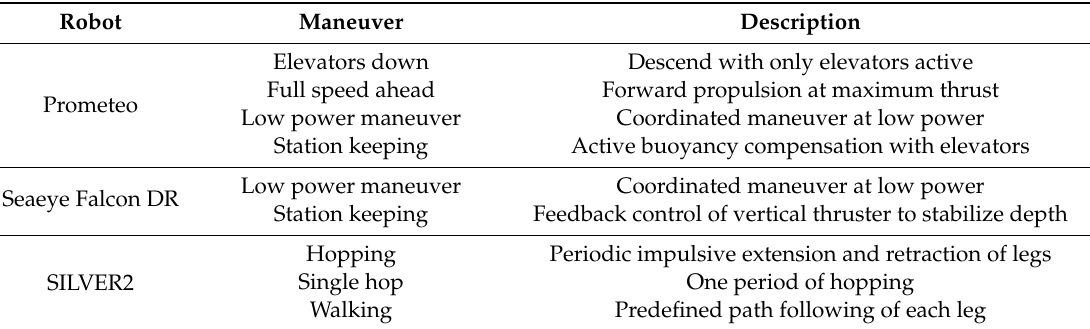
Table 2. All the maneuvers performed by the robots in this study.